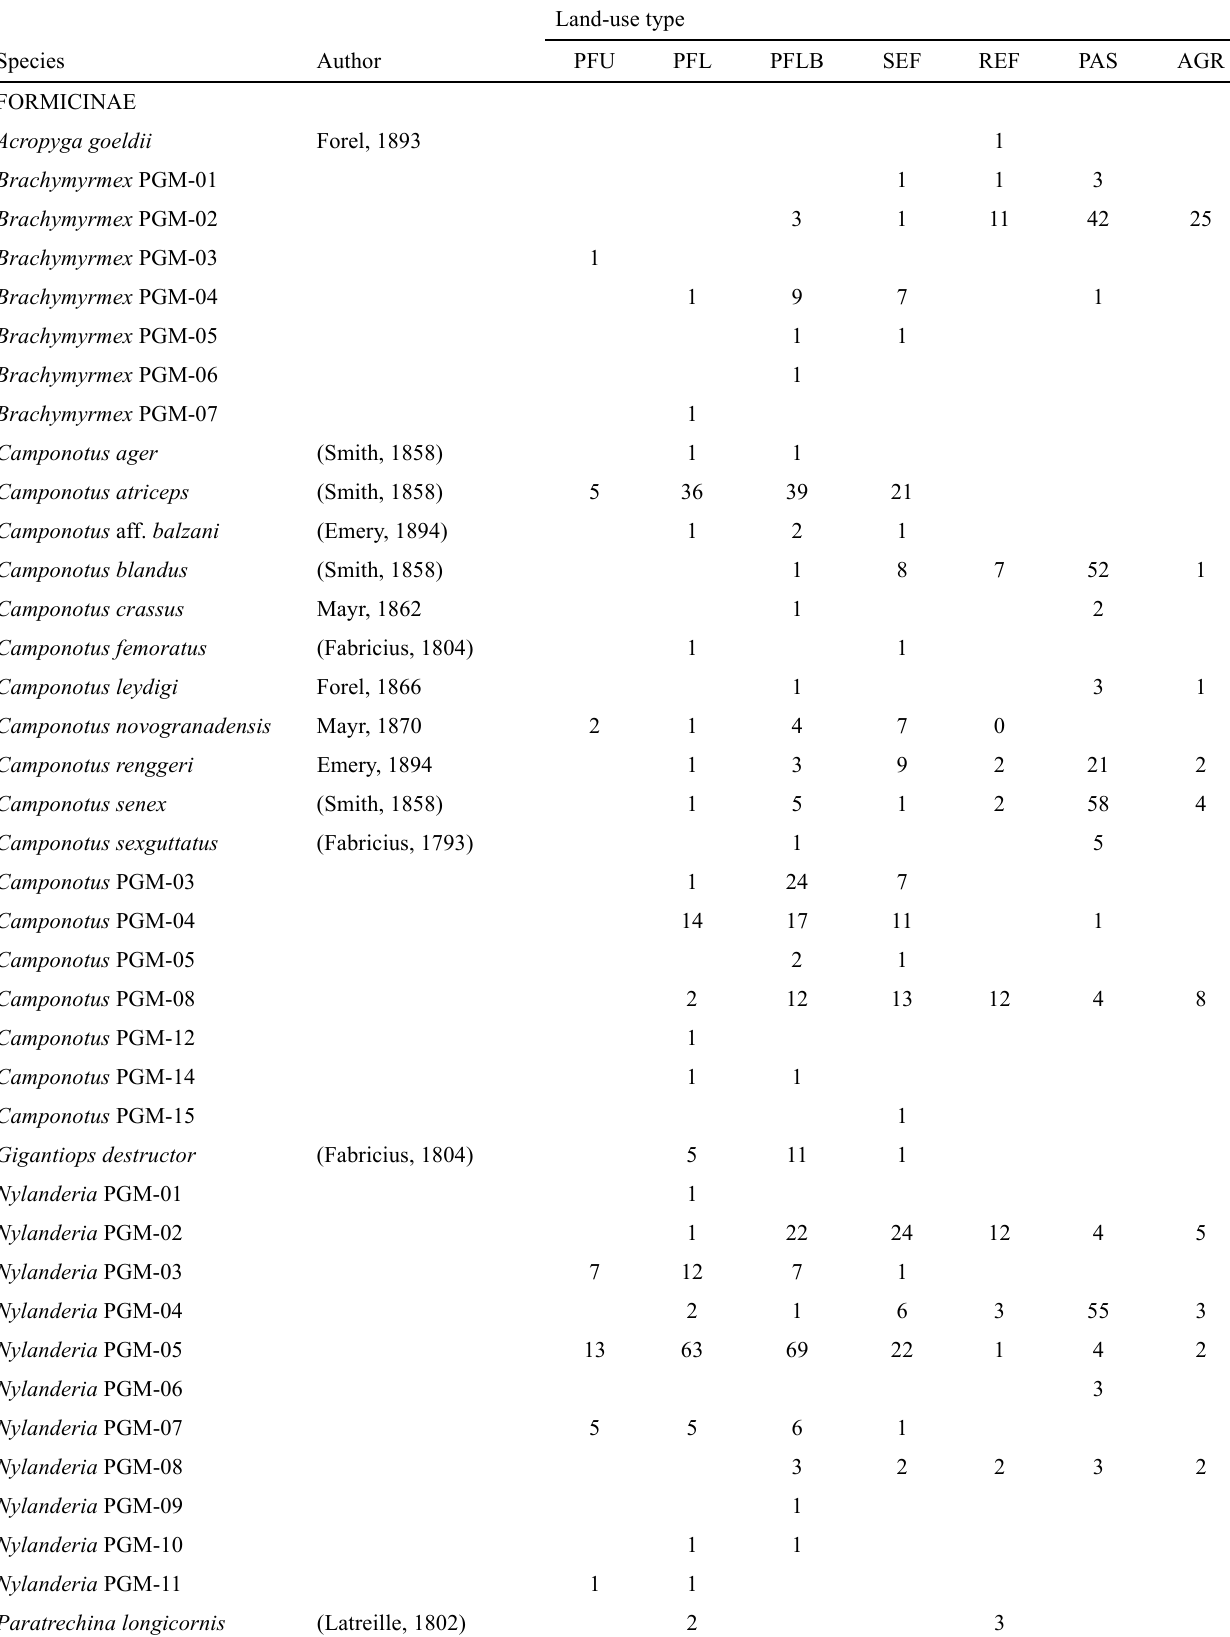
Table 2 . List of ant species collected in this study. Values represent number of records per pitfall traps of each species in each land-use type: PFU – primary forest undisturbed, PFL – primary forest logged, PFLB – primary forest logged and burnt, SEF – secondary forest, REF – reforestation with commercial species, PAS – pasture, AGR – agricultural areas.